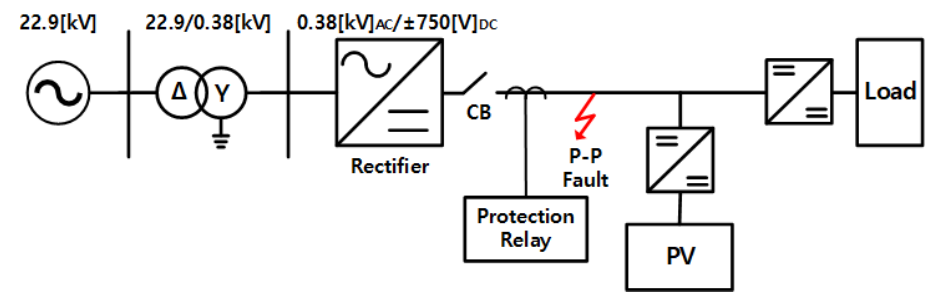
Figure 1. Modelling of low voltage direct current (LVDC) System.